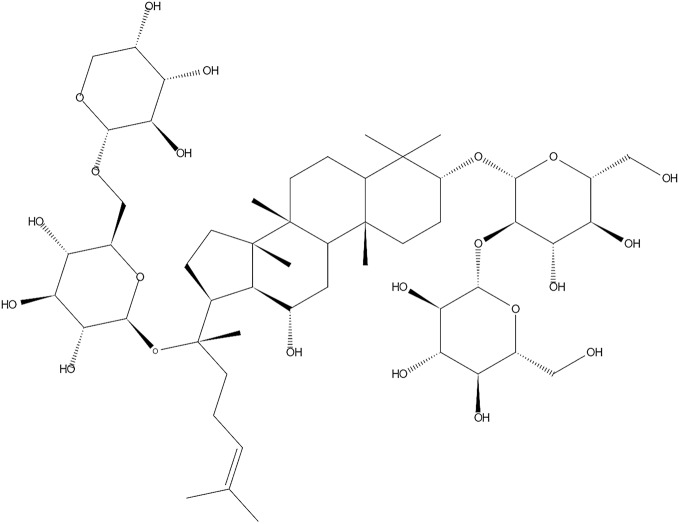
Chemical structures of G-Rb1.